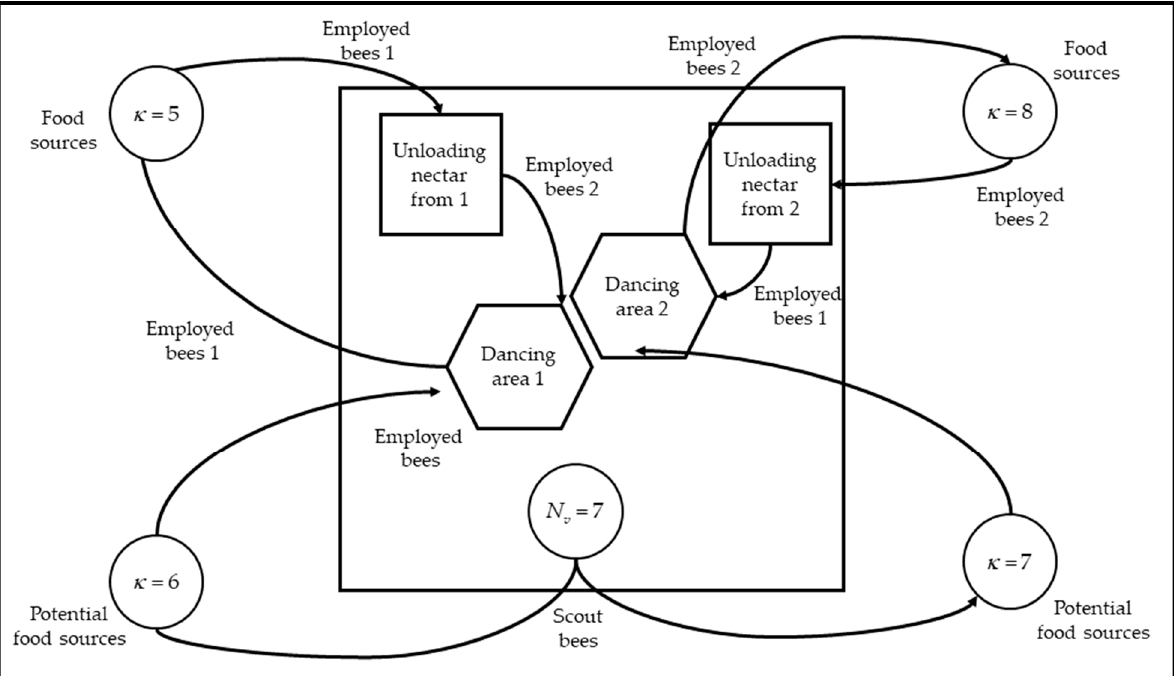
Figure 3. Schematic diagram of ABC optimizing logic phase. Algorithm 1. The pseudocode of ABC in the logic phase: